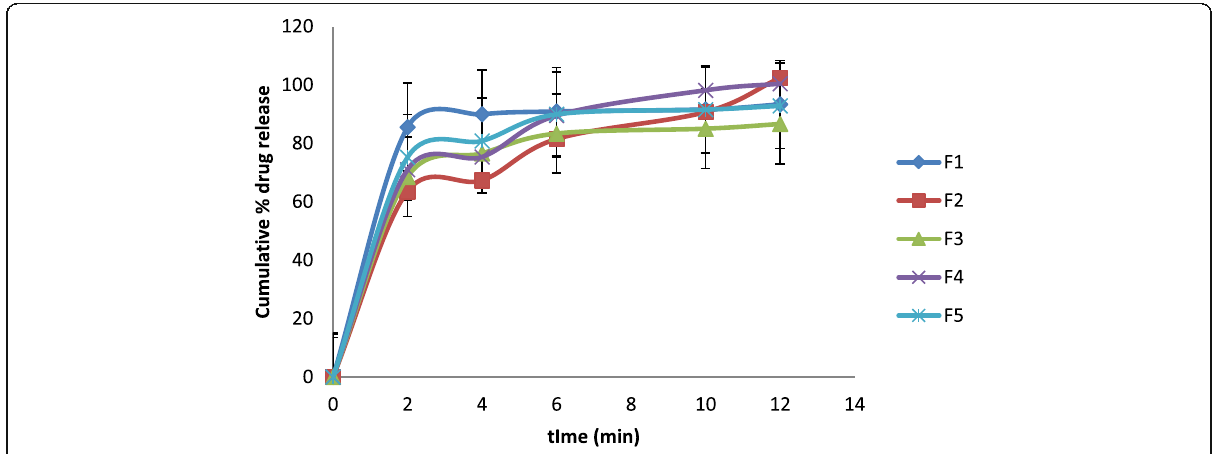
Fig. 4 Cumulative percentage release of drug from formulations F1 to F5. Values were expressed mean ± SD, n =